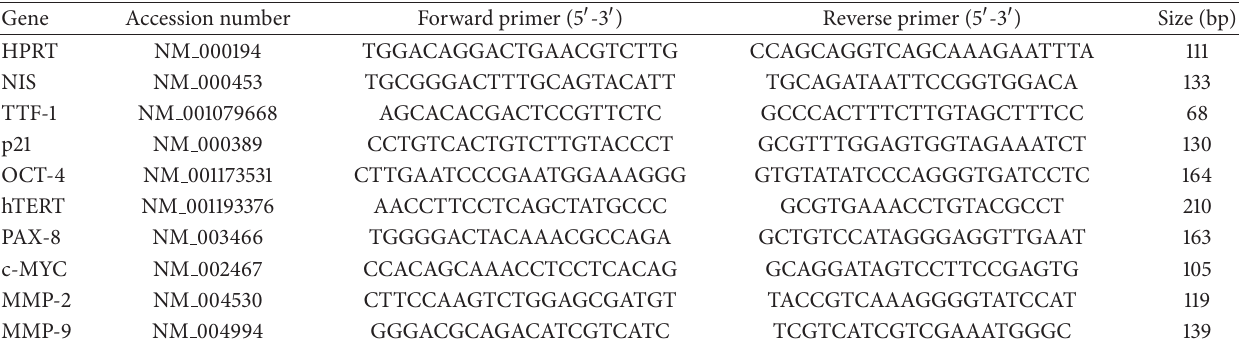
Table 1: Primer sequences for quantitative RT-PCR.